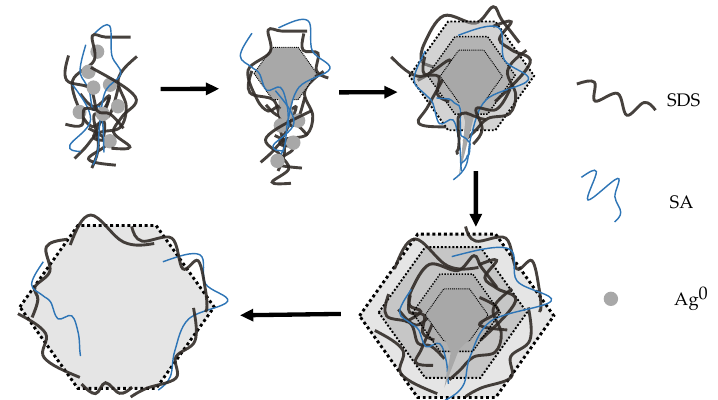
Figure 3. Schematic of the growth of nanoplates during the synthesis of SNPs under 0 °C.